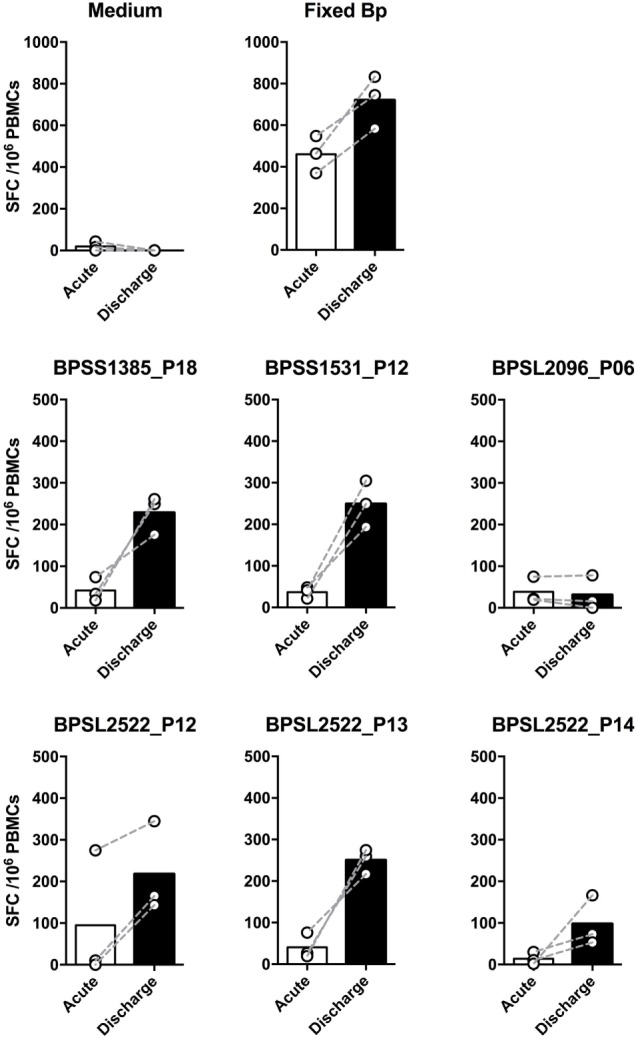
Comparison of IFNγ responses to top six T-cell immunoprevalent peptides of Burkholderia pseudomallei (Bp) in patients with a diagnosis of acute melioidosis at the time of acute admission and following recovery having completed antibiotic treatment. Peripheral mononuclear cells (PBMCs) from patients diagnosed with acute melioidosis were cultured with medium only control, paraformaldehyde (PFA) fixed Bp, or T-cell immunoprevalent peptides for 48 h. IFNγ induction was quantified by ELISpot. The results show the comparison of individual IFNγ responses between samples taken on admission (acute, white bar) and discharge (day 30, black bar) from the same patients (n = 3). The differences were not statistically significant using Wilcoxon matched-pairs signed rank test.